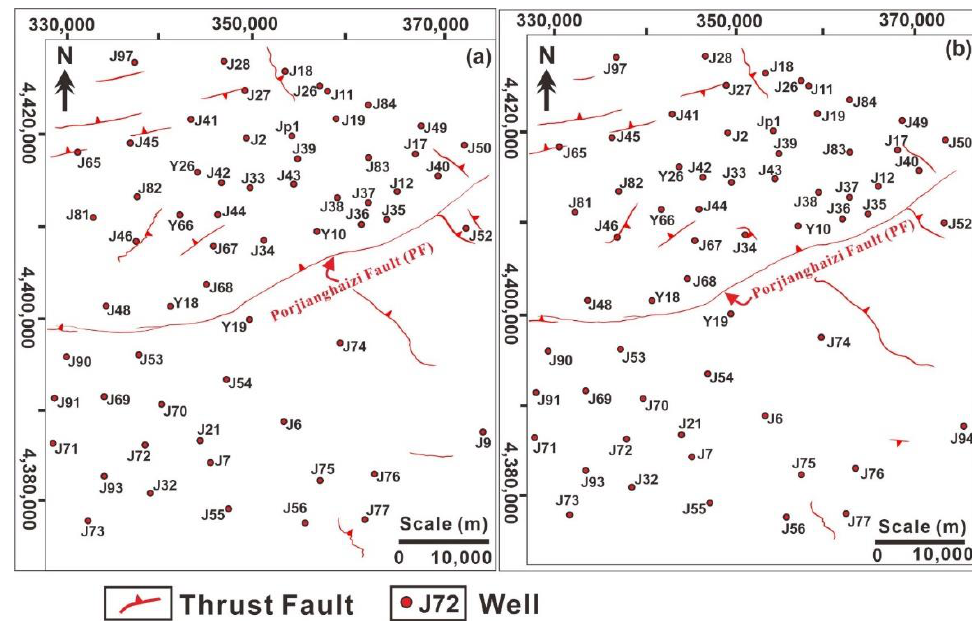
Figure 8. Interpretation of faults distribution and horizon slices of ( a ) T9d and ( b ) T9e.